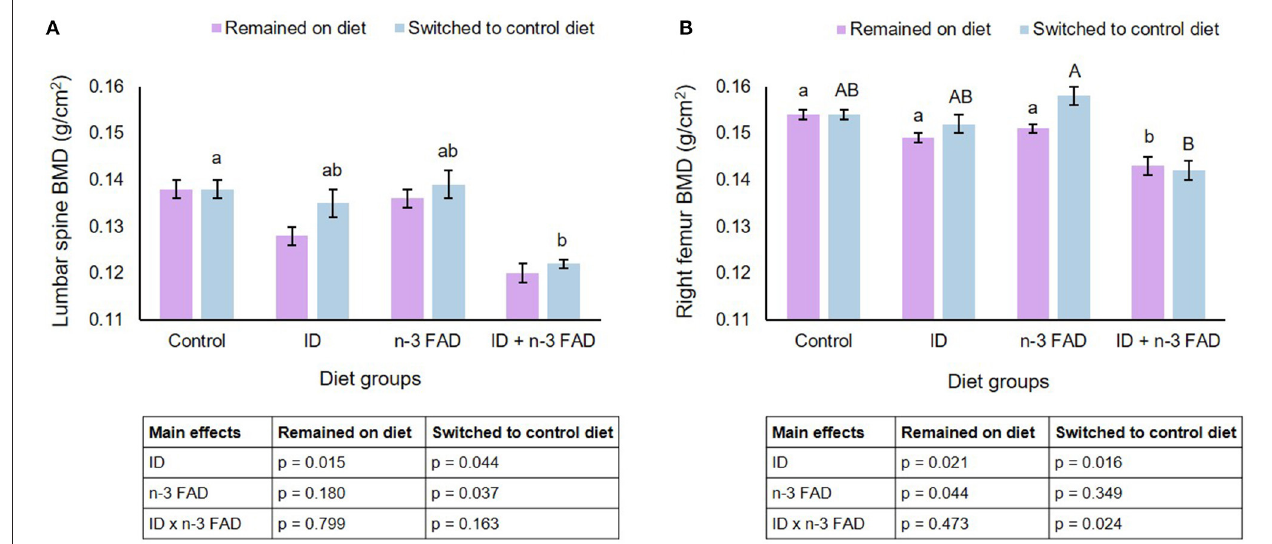
FIGURE 2 | Lumbar spine and right femur bone mineral density. Two-way ANCOVA was used to test effects of ID, n-3 FAD, and ID x n-3 FAD interactions, adjusted for sex and body weight. Spine and right femur BMD were log transformed to perform ANCOVA. Between-group differences were determined using one-way ANCOVA followed by Bonferroni’s post-hoc test (adjusted for sex and body weight). Values are unadjusted geometric means ± SEM for log transformed variables. Means with superscripts without a common (capital or small) letter differ ( P < 0.05). ID, iron deficiency; n-3 FAD, omega-3 fatty acid deficiency; BMD, bone mineral density.